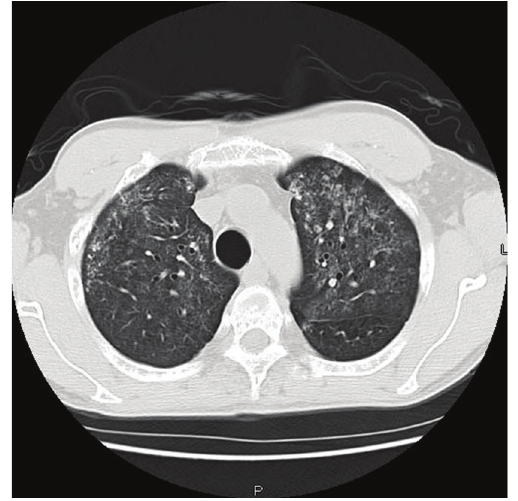
Figure 2: Chest CT showing ground-glass nodular opacities, with poorly defined nodules.